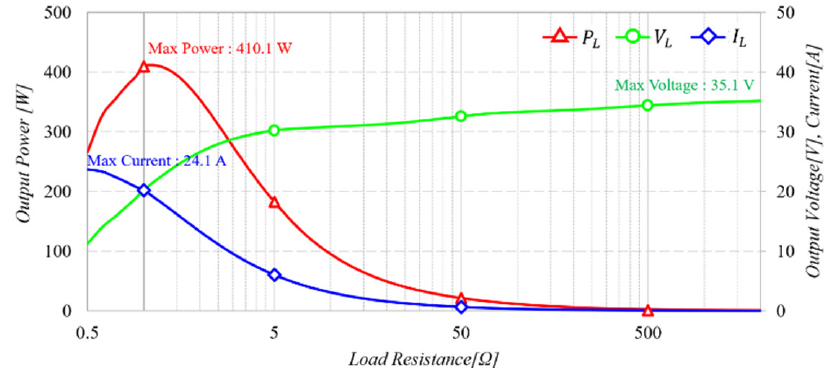
Figure 14. Experimental results on the output characteristics from short to open loads of the proposed design method.